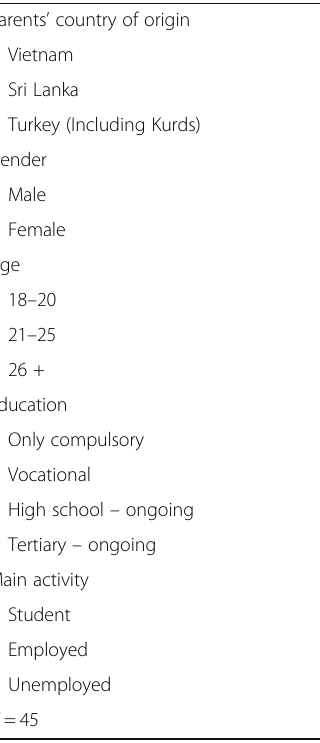
Table 1 Interviewee ’ s main